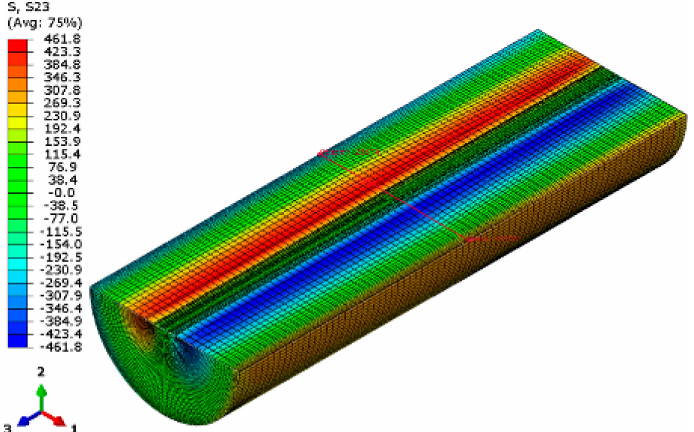
Figure 8. Numerical finite element method (FEM) model of the cylindrical specimen subjected to pure torsion at the maximum presetting shear strain of 4.3%, and the residual shear stress distribution after unloading, according to technology